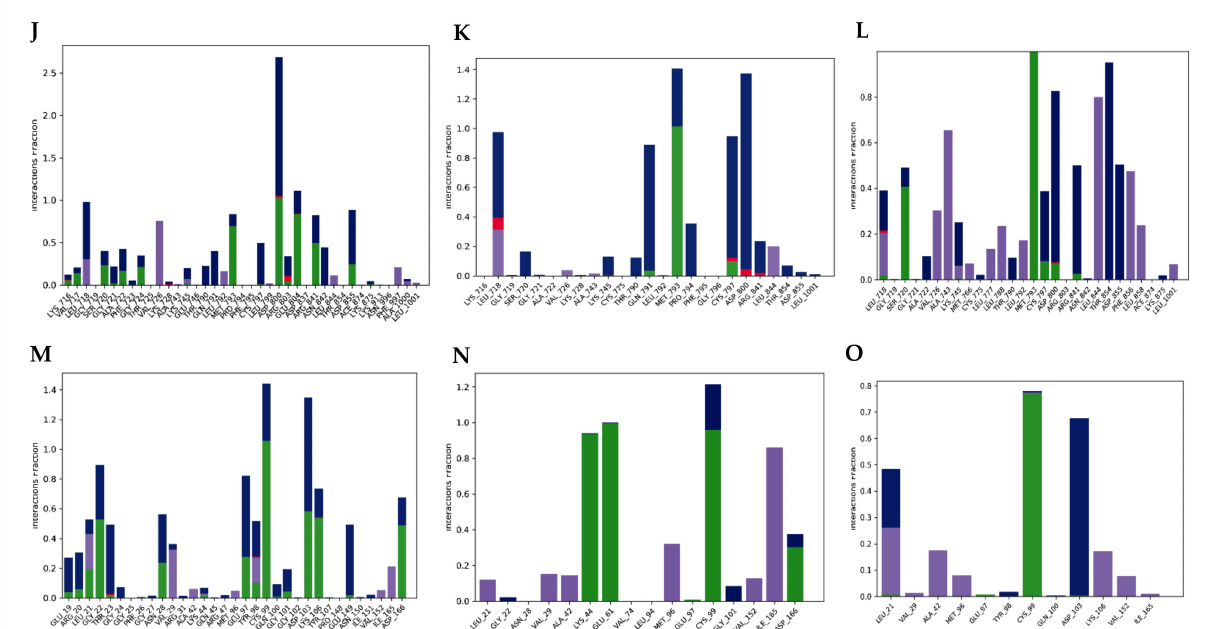
Figure 7. Interaction histogram. ( A – C ) COX-1 complexed with FA, VA, and DIF; ( D – F ) COX-2 complexed with SA, VA, and ETO; ( G – I ) LOX-5 complexed with PA, RU, and NDGA; ( J – L ) EGFR complexed with RU, PA, TAK-285; ( M – O ) IKK complexed with RU, FA,